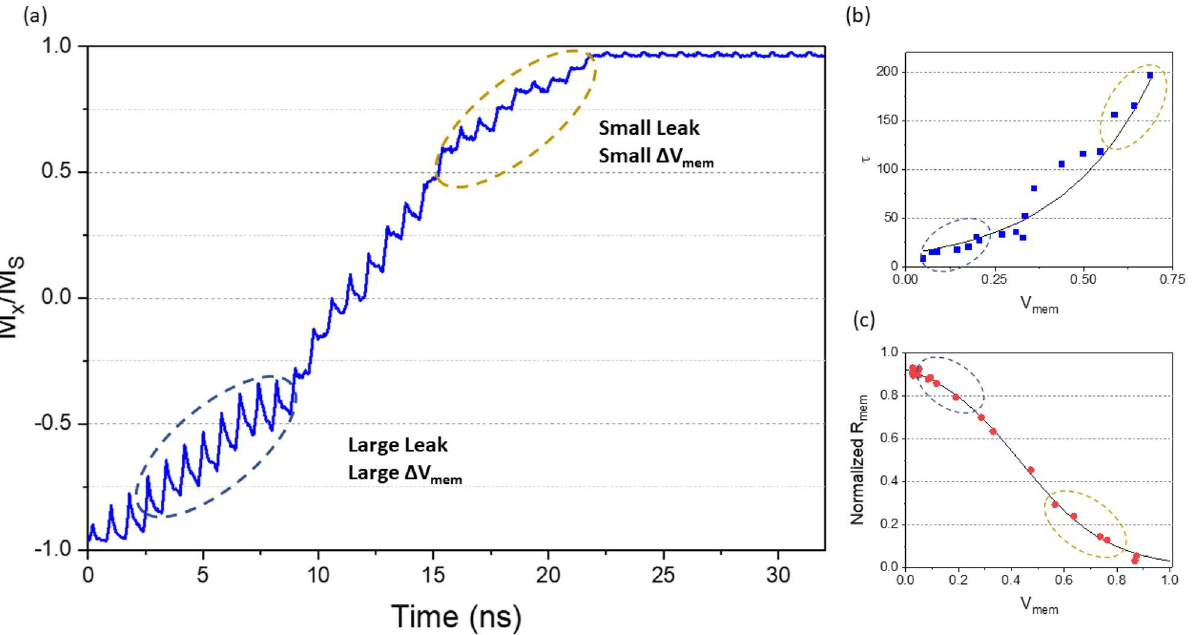
Figure 3. Detailed analysis of the dynamic behavior of the simulated device. ( a ) The magnetization versus time under the stimulus of input spike sequence. ( b ) Leak time constant τ versus the instantaneous V mem . Data points (blue squares) are extracted from the plot in ( a ), and numerically fitted by Eq. (3). ( c ) Normalized membrane resistance R mem versus the instantaneous V mem . Data points (red dots) are extracted from the plot in ( a ), and numerically fitted by Eq.